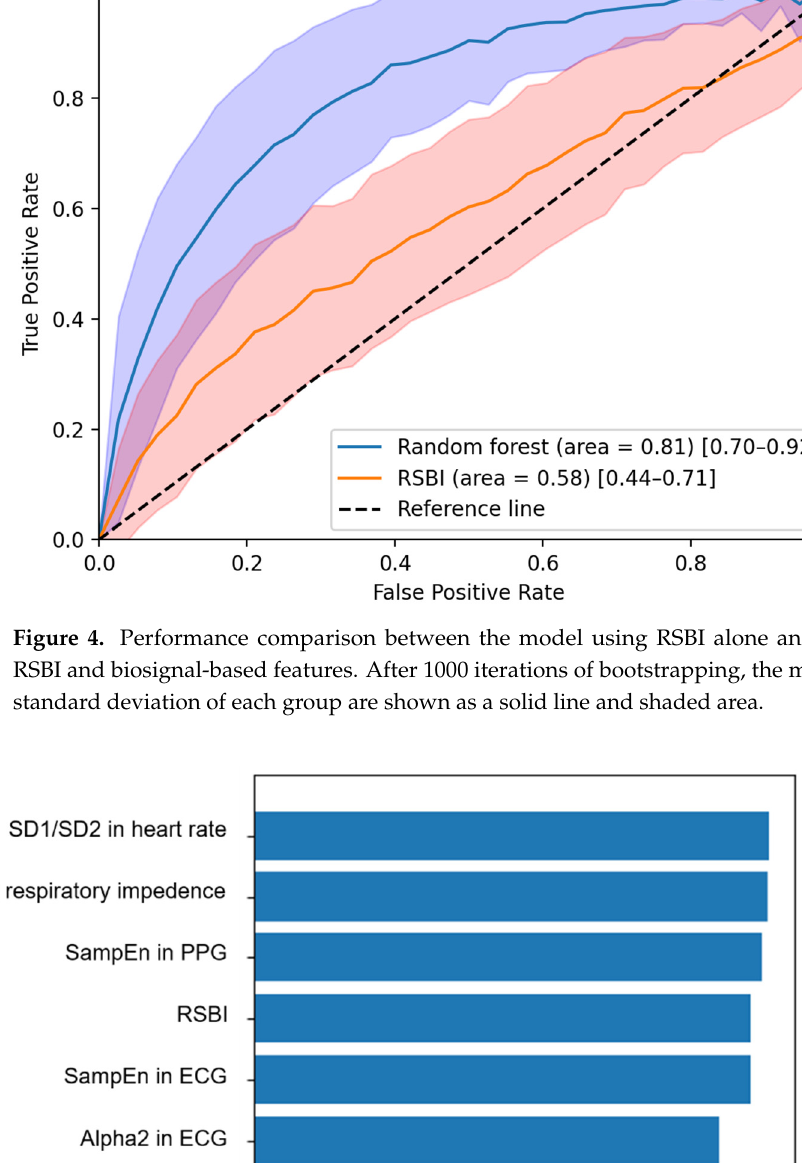
11 of 19 Table 3. Performance indices (accuracy, sensitivity, specificity, positive predictive value, negative predictive value, and F-1 score).